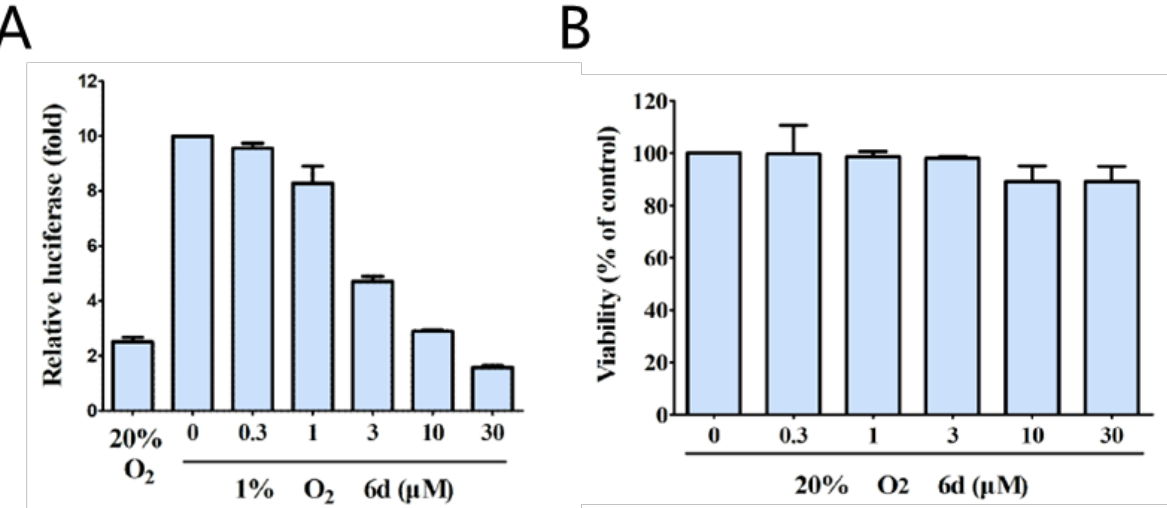
Figure 2. Effect of compound 6d on pNF- κ B-mediated reporter gene expression. ( A ) HeLa cells were transiently co-transfected with a NF- κ B luciferase and pRL-CMV vectors. Following 24 h incuba- tion, the cells were incubated under hypoxia in the absence or presence of the indicated